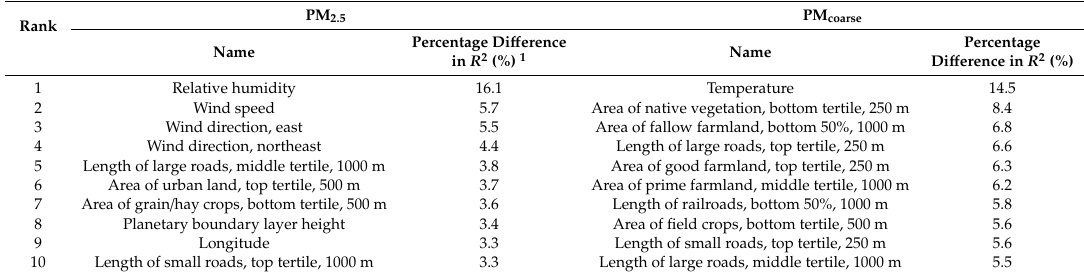
Table 5. Variable